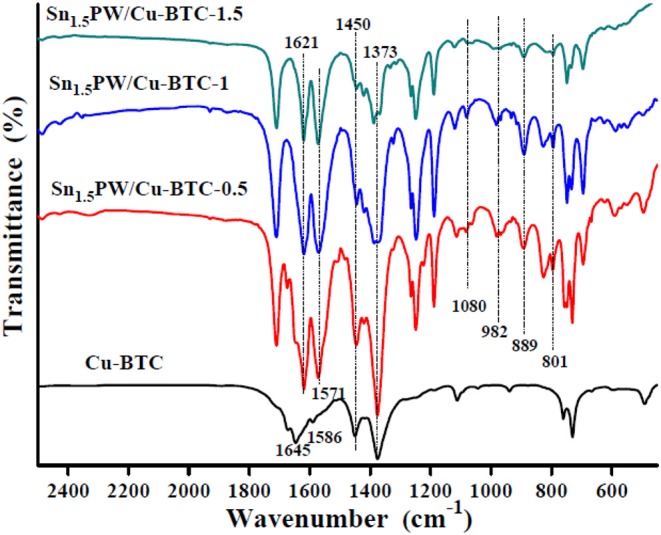
FTIR spectra of the Cu-BTC and Sn1.5PW/Cu-BTC-x hybrids.